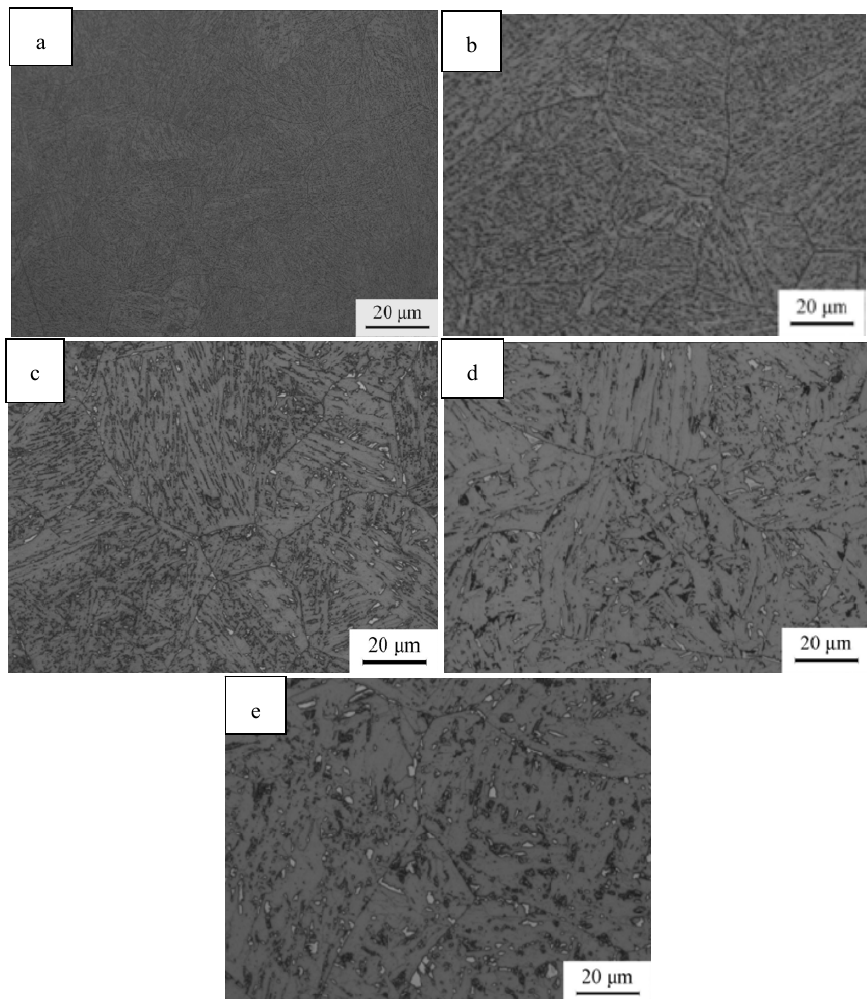
Figure 10. M-A morphology of the simulated CGHAZ at different heat input: ( a ) 18 kJ/cm; ( b ) 25 kJ/cm; ( c ) 31 kJ/cm; ( d ) 44 kJ/cm; and ( e ) 81 kJ/cm.